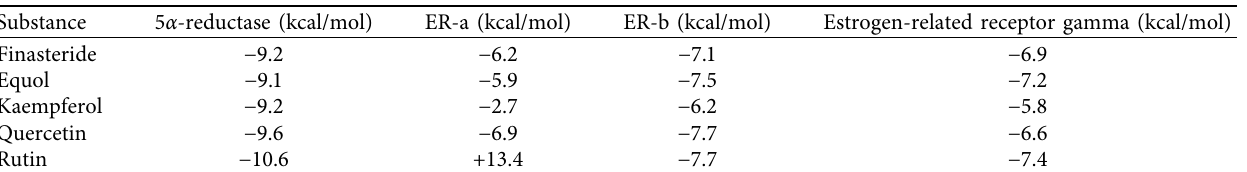
Table 4: Binding affinity of the finasteride, equol, kaempferol, quercetin, and rutin to 5 α -reductase, estrogen receptor alpha and beta, and estrogen-related receptor gamma.